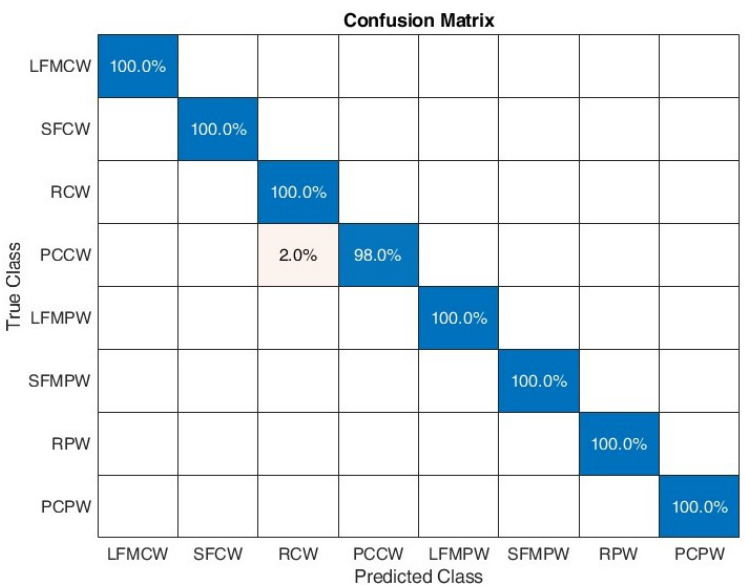
Figure 16. Confusion matrix for SNR in range [0:10]